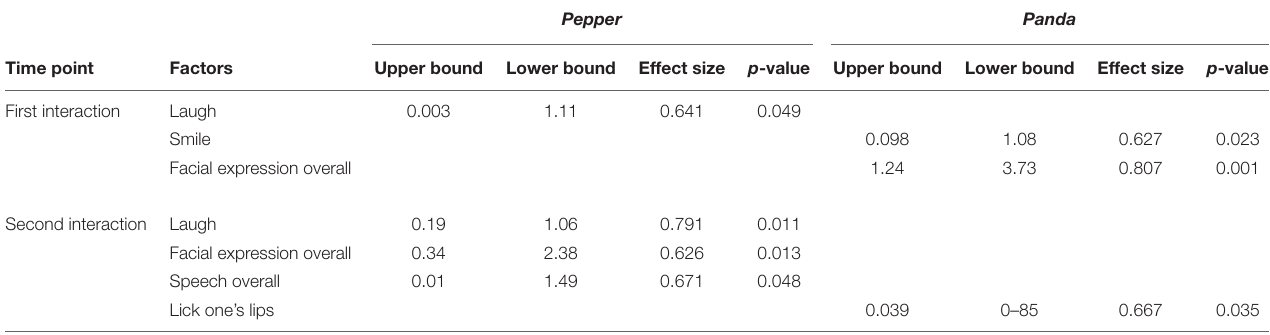
TABLE 4 | The table shows the results of the reaction of the participants after an error of the robot for both robots in comparison between the condition groups (see also section “Specific reactions after an error by the